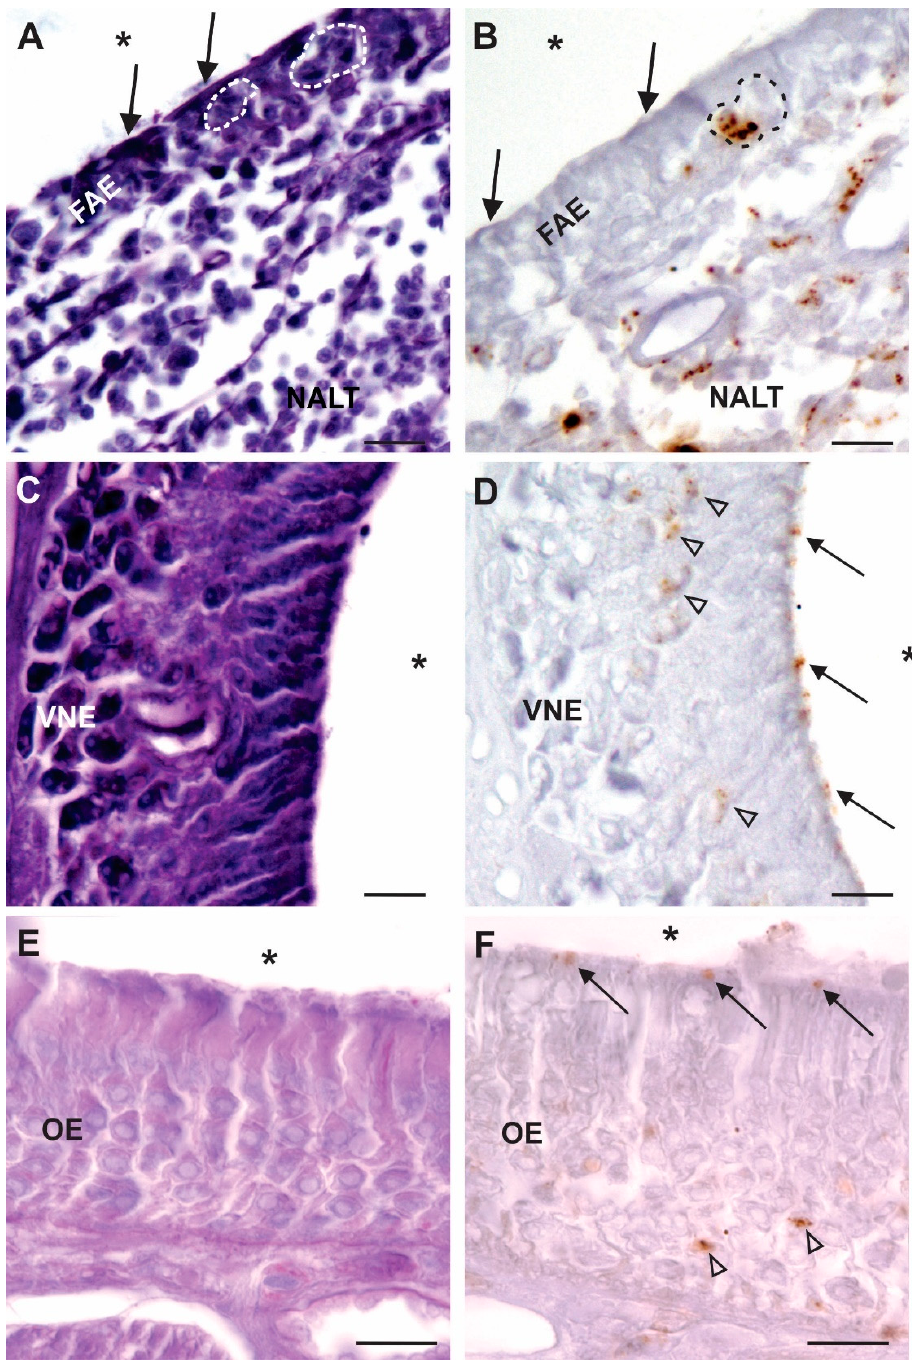
Figure 3. PrP Sc in the NC of clinically ill hamsters following inhalation of prions into the NC (asterisks indicate airspace of the NC). ( A , C , E ) Periodic acid Schiff-stained sections, and ( B , D , F ) near- adjacent immunohistochemically processed tissue sections for the presence of PrP Sc using the 3F4 antibody. ( A , B ) PrP Sc in intraepithelial pockets (indicated by dotted lines) of the follicle-associated epithelium (FAE) and the underlying nasal associated lymphoid tissue (NALT). ( C , D ) PrP Sc in the vomeronasal epithelium (VNE), in both the cell bodies (indicated by arrowheads) and apical surfaces of the sensory neurons (indicated by solid arrows). ( E , F ) PrP Sc can be seen in the OE, in the OSN cell bodies (indicated by arrowheads), and in dendrites at the apical surfaces of the cells (indicated by solid arrows). Scale bars = 10 µ